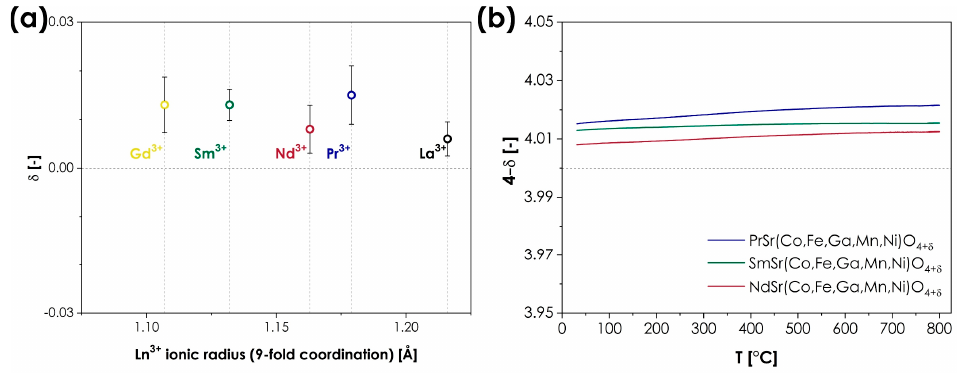
Figure 3. ( a ) Room temperature oxygen non-stoichiometry in the LnSr(Co,Fe,Ga,Mn,Ni)O 4+ δ (Ln = La, Pr, Nd, Sm, or Gd) series, in a function of ionic radius of Ln 3+ cations; ( b ) temperature dependence of oxygen non-stoichiometry for the single-phase compositions.